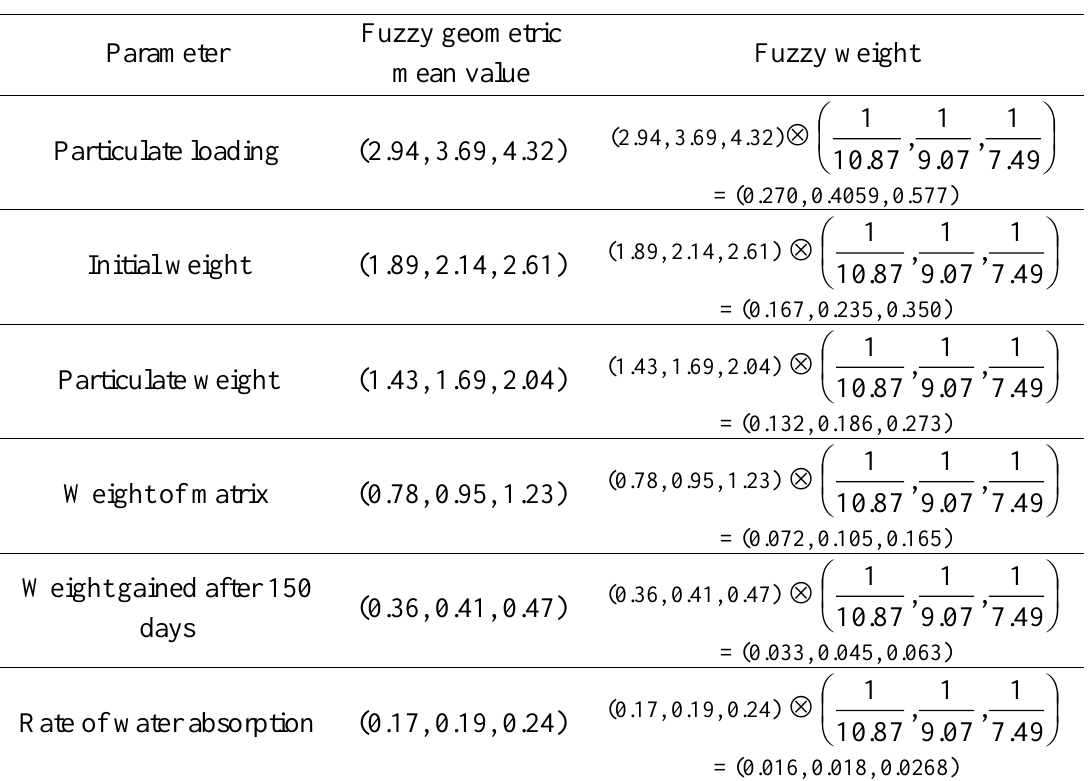
Table 5. Fuzzy weights for parameters.